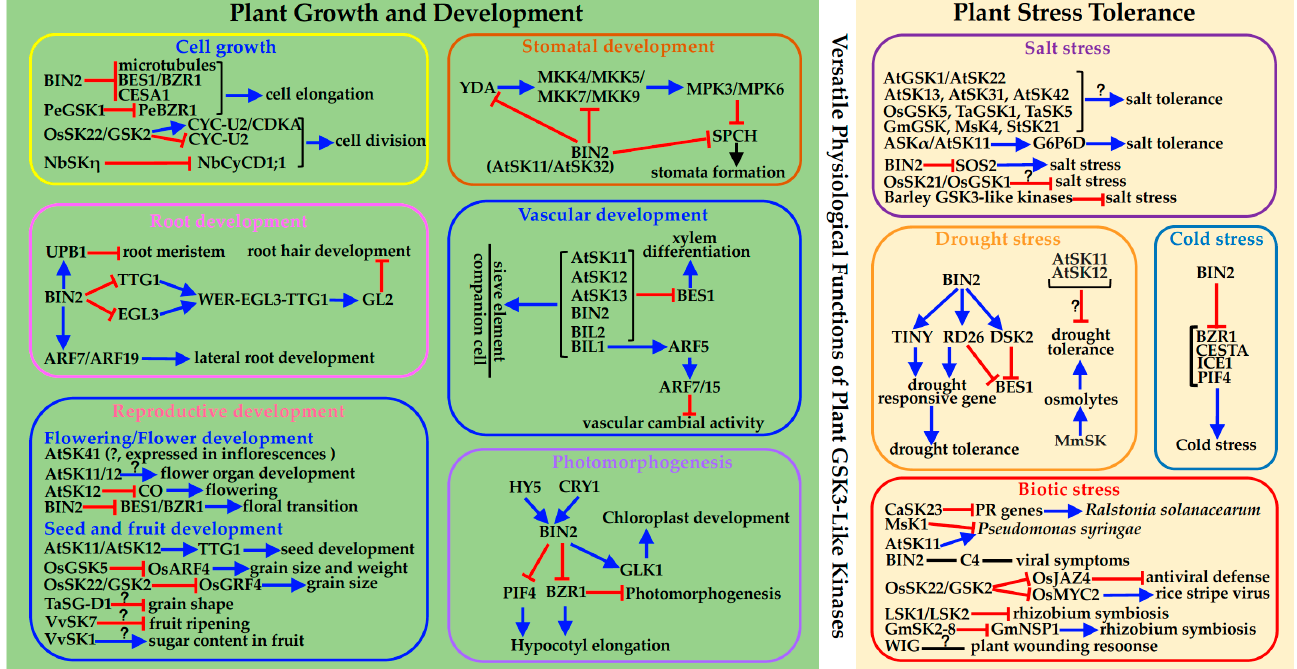
Figure 1. A graphic summary of known physiological functions of plant GSK3-like kinases. The blue and red ⊣ indicate stimulatory and inhibitory effects/interactions between indicated proteins and their interacting proteins or listed developmental/physiological processes, respectively. The question marks denote unknown mechanisms by which indicated GSK3-like kinases influence plant physiological/developmental processes.